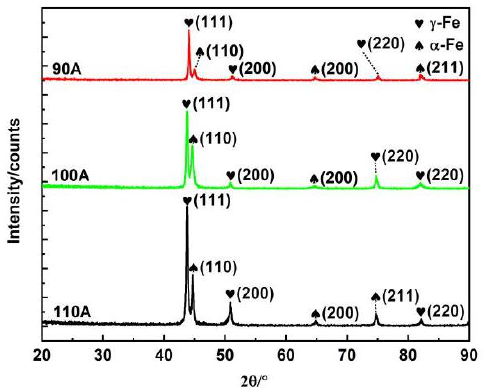
Figure 6. XRD results of 2205 DSS cladding layer under different current.